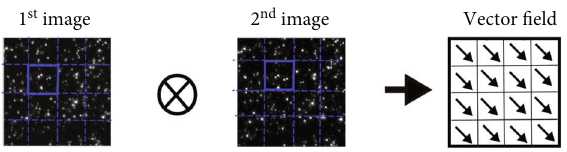
Figure 3: Cross-correlation algorithm for PIV measurement.